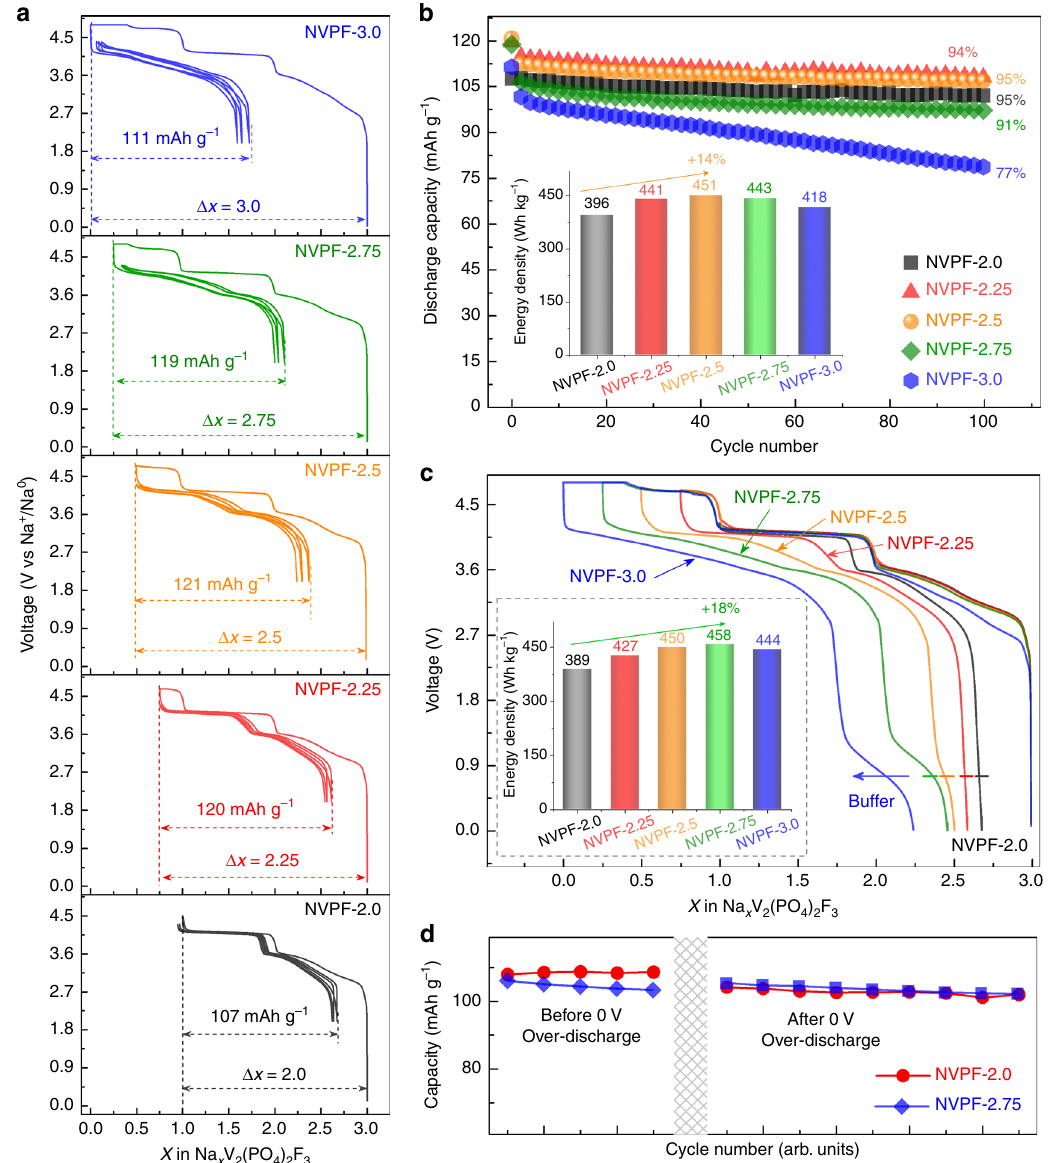
Fig. 8 Electrochemical performance of NVPF/C full cells. The voltage-composition curves a and cycling performance b of NVPF/C full cell of NVPF-2.0, 2.25, 2.5, 2.75, and 3.0 samples cycled between 4.3 and 2.0 V after fi rst activation process up to 4.8 V at C/10 followed a potentiostatic charging until reaching the exact amount of Na + content, where insets in b is the histogram of the discharge energy density based on the mass of NVPF. c The voltage- composition curves of NVPF/C full cell of NVPF-2.0, 2.25, 2.5, 2.75, and 3.0 sample cycled down to 0 V with the inset showing the histogram of energy density based on the mass of NVPF. d The cycling performance of NVPF-2.0 and NVPF-2.75 in a full cell before and after zero volt over-discharge tests